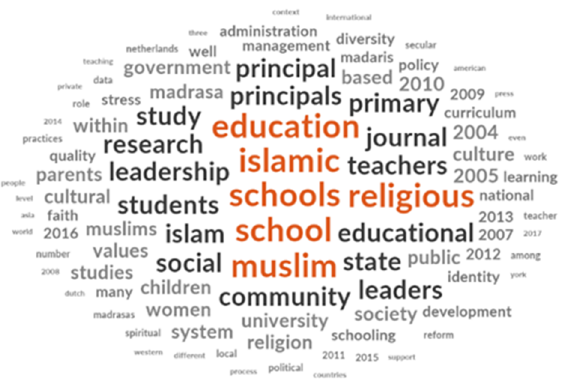
Figure 5. The most frequent 100 words in the selected studies.